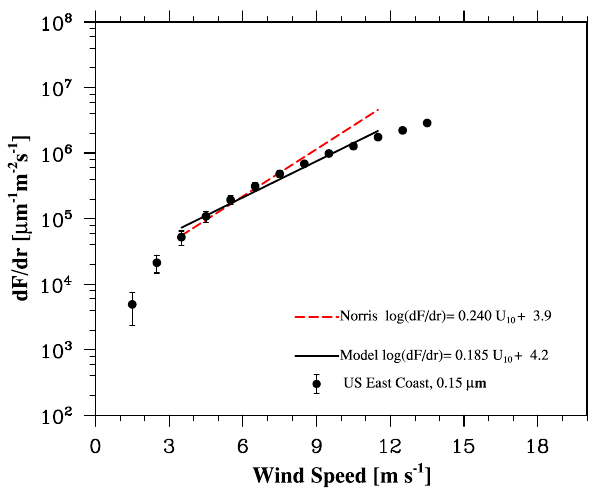
Fig. 13. Emission fluxes of 0.15µm dry radius sea-salt at different wind speeds. The dots with error bars are the model parameterized emission fluxes. The solid line is the log-linear fit for wind speed range 4–12ms − 1 . The dashed line is the emission flux by Norris et al. (2008). The model values were averaged over the area of ship measurement at the United States east coast (24–36 ◦ N, 50–77 ◦ W). The model used the CMS source function and a solubility factor of